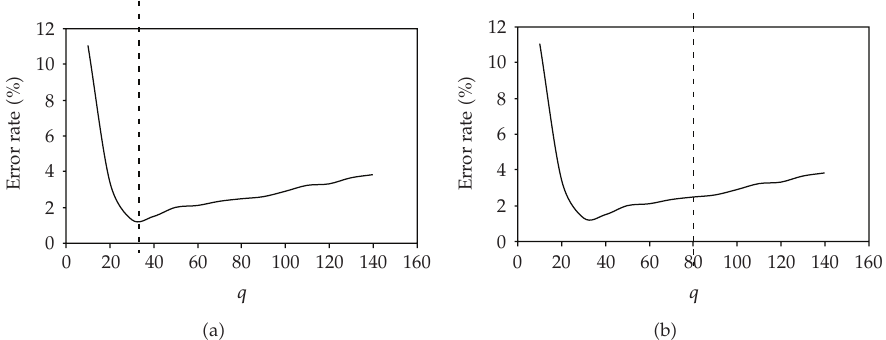
Figure 6: Recognition performances of NPE in term of average error rate on (cid:2) a (cid:3) Essex94 and (cid:2) b (cid:3) FRGC